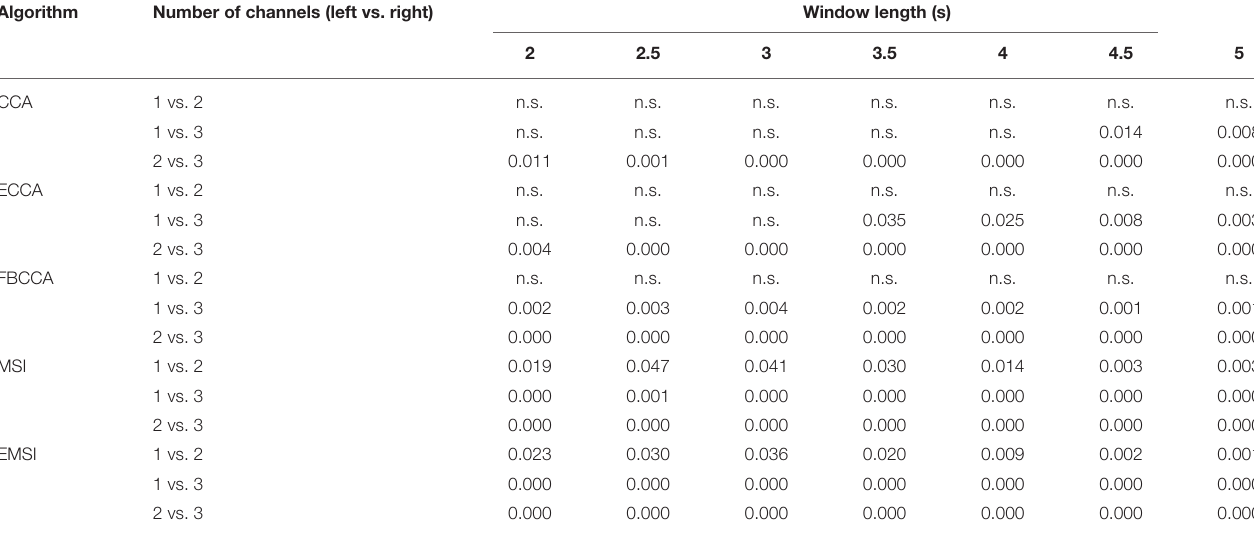
TABLE 2 | Bonferroni corrected p -values of post-hoc analysis among the average classification accuracies across the electrode shift (ACAs) of three different numbers of channels for classification algorithm and window length. Algorithm Number of channels (left vs.